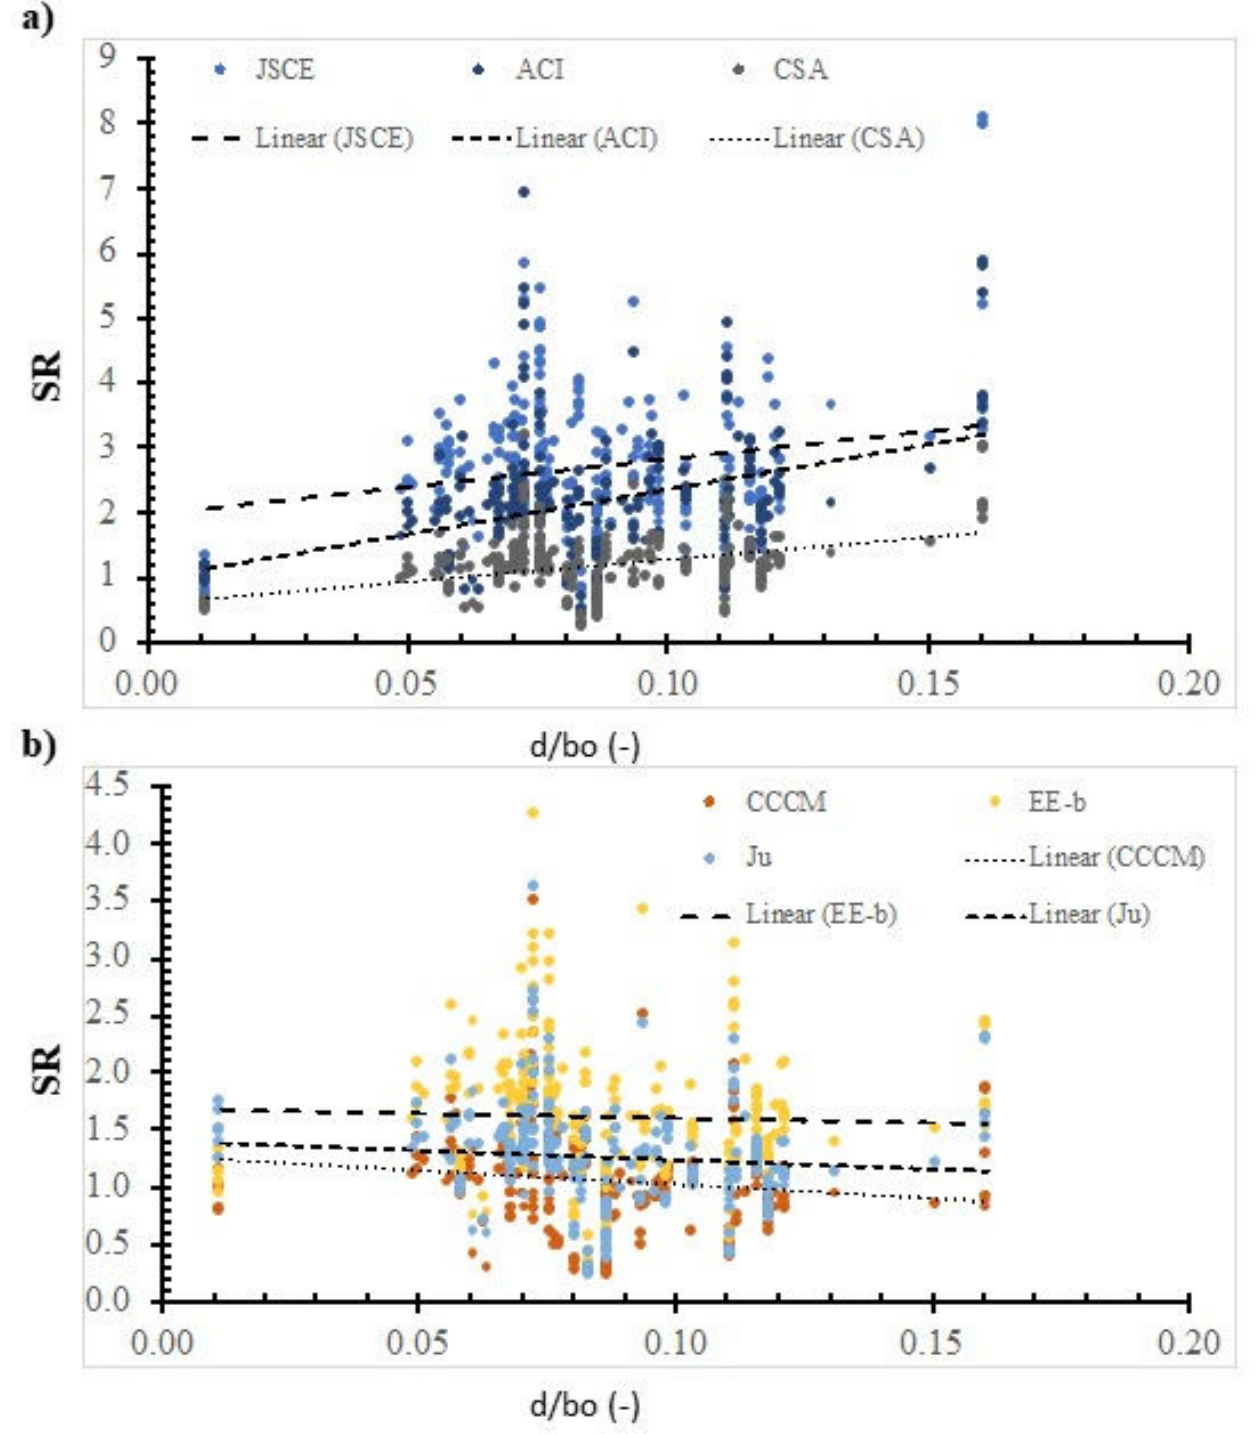
Figure 10. The effect of the ratio between the control perimeter and depth on the SR value, calculated using selected models. ( a ) Design codes; ( b )